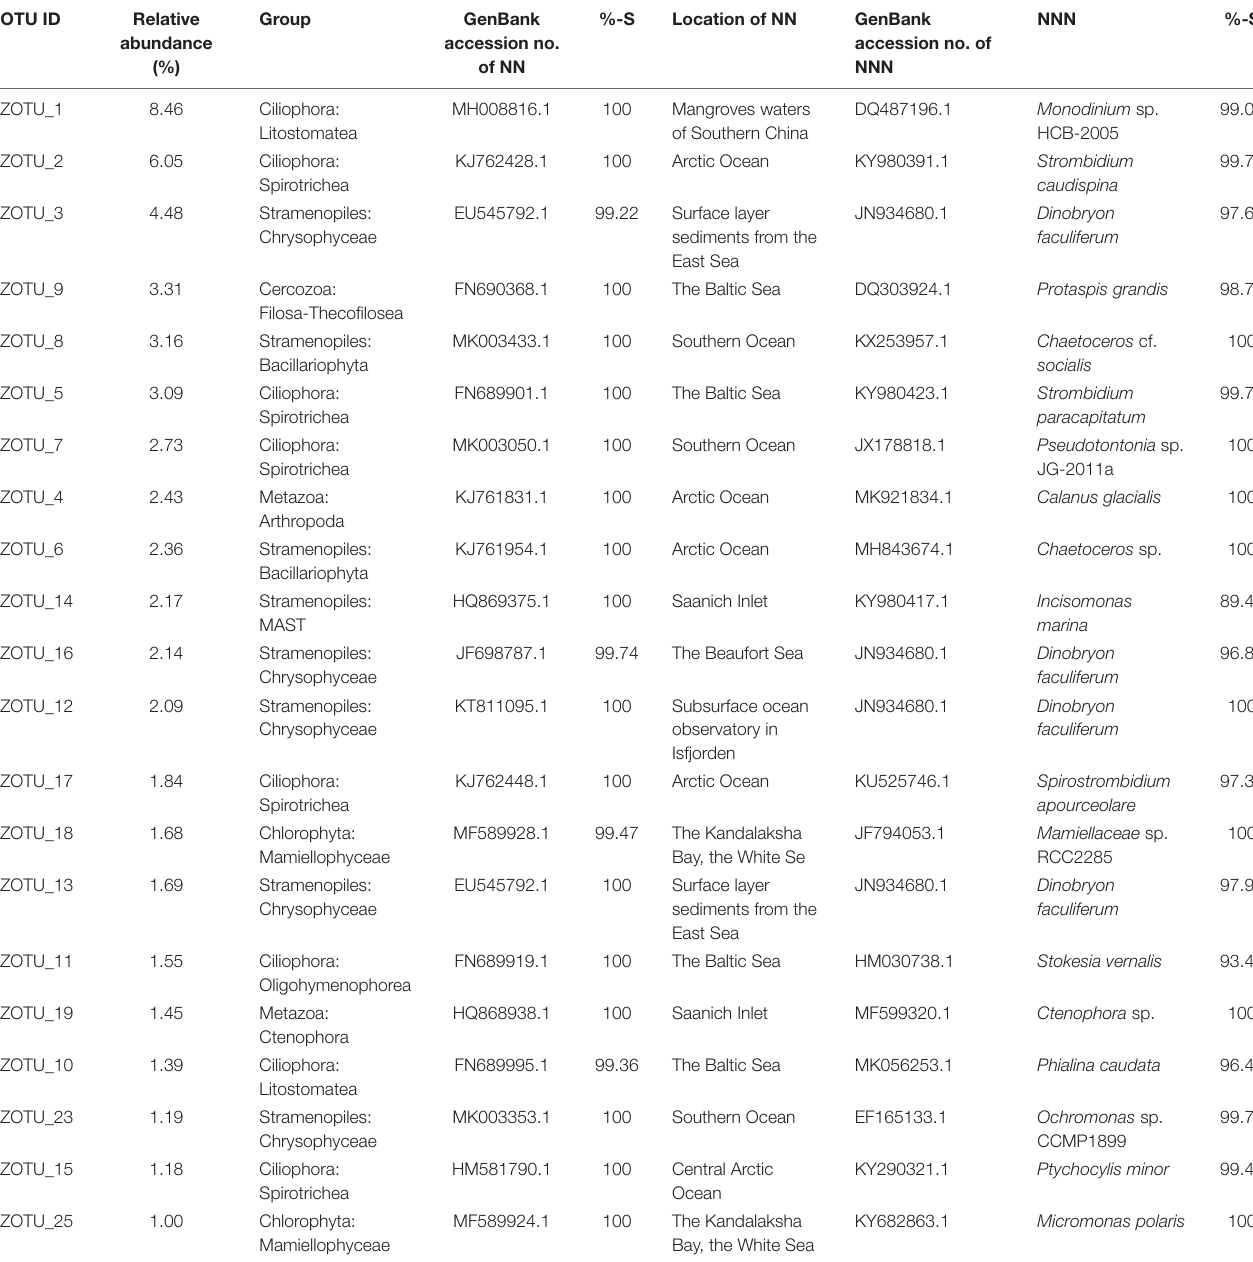
TABLE 1 | List of the most abundant 21 ZOTUs in the pooled dataset with the relative abundance of sequences, taxonomic identification, GenBank accession number of the nearest neighbor (NN), similarity (%-S) with NN, the location of where NN was reported, GenBank accession number and the identification of the nearest named neighbor (NNN), and similarity (%-S) with the NNN.